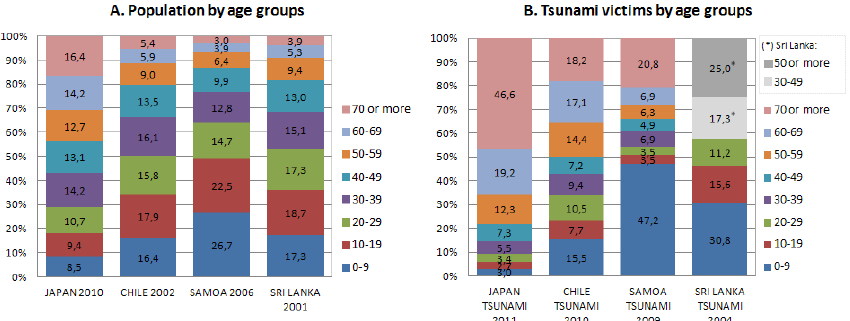
Figure 2. Age groups analysis (tsunami events of Japan 2011, Chile 2010, Samoa 2009 and Sri Lanka 2004): (a) pre-tsunami census, (b) tsunami victims. The age of tsunami victims over 30 years old in Sri Lanka is not available disaggregated in ranges of